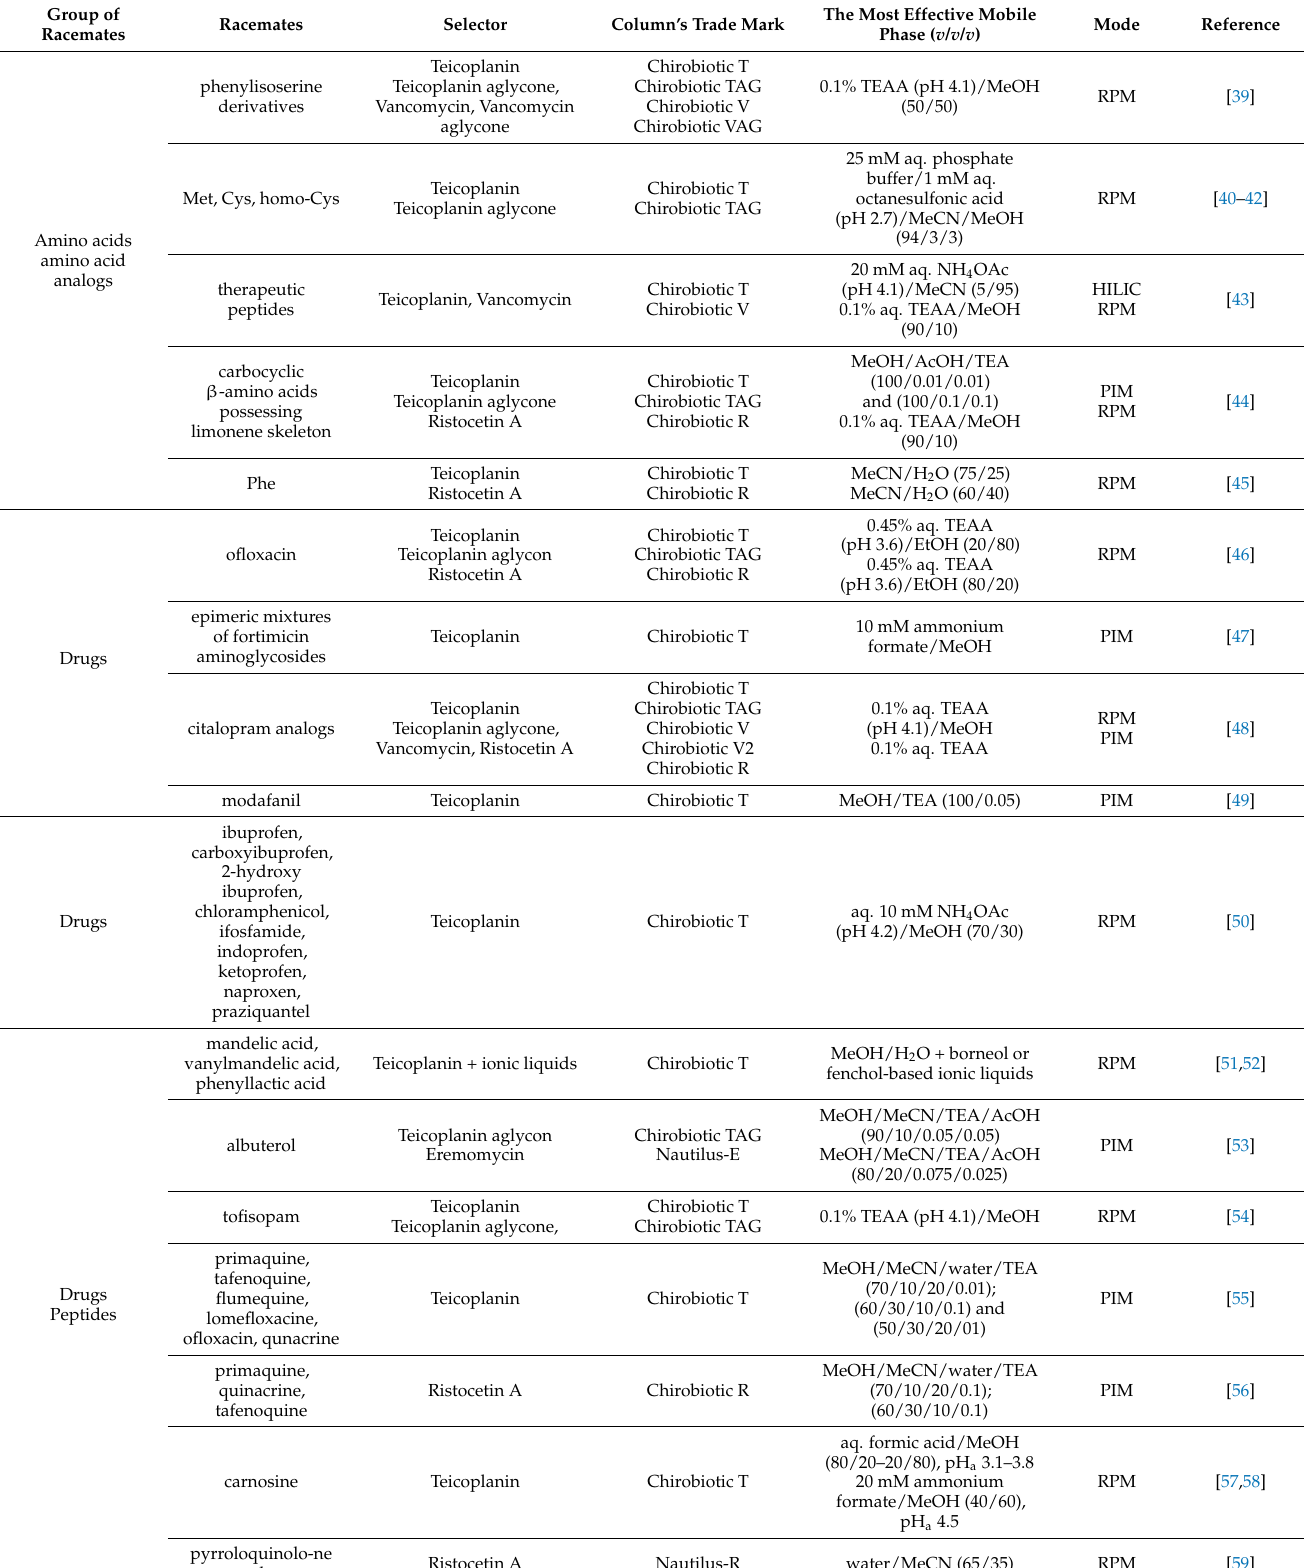
Table 4. Enantioseparation of stereoisomers of different analytes on teicoplanin, teicoplanin aglycon, vancomycin and on ristocetin A-based CSPs.